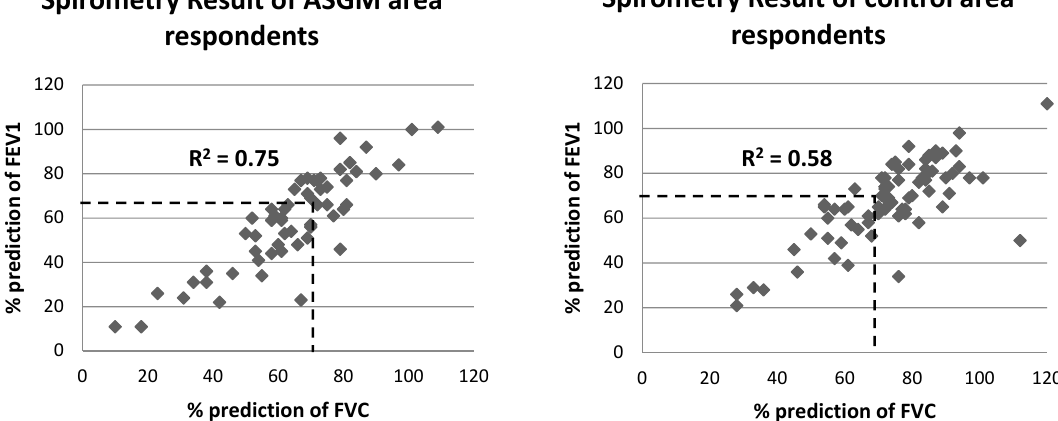
Figure 2. Correlation between Force Vital Capacity (FVC) and Forced Expiratory Volume in 1 s (FEV1) in ASGM (artisanal and small-scale gold mining) and control areas. Area laid below the dotted line express the abnormal results of FVC and FEV1 representing the interpretation of spirometry test result. Table 2. Respiratory assessment result by smoking grade, Forced Vital Capacity (FVC), Forced Expiration Volume in 1 s (FEV1), and spirometry interpretation.